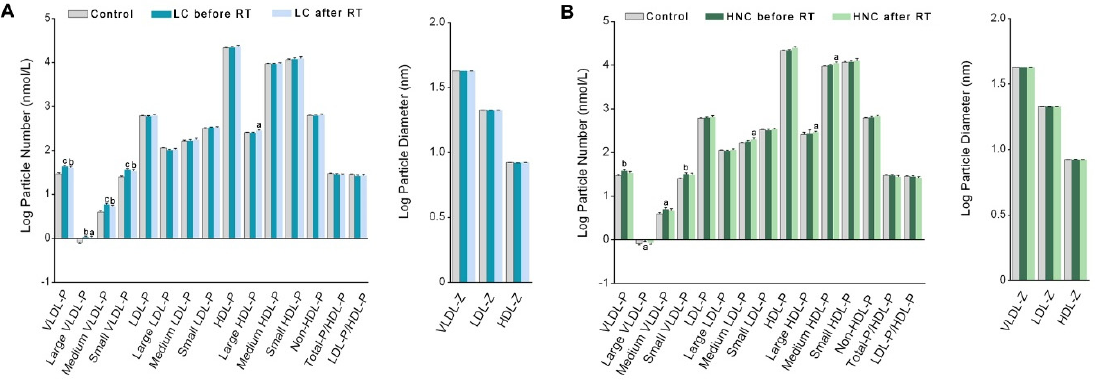
Figure 2. Number and diameter of the different lipoprotein particles in patients with lung cancer (LC) ( A ), head and neck cancer (HNC) ( B ) before and after radiotherapy (RT) and in the control group. Values are log transformed due to the high variability of particle sizes and numbers. Results are shown as means and standard errors. HDL: high-density lipoproteins; IDL: intermediate-density lipoproteins; LDL: low-density lipoproteins; VLDL: very-low-density lipoproteins. The suffix –P indicates number of particles, and the suffix –Z indicates the particle diameter. a p < 0.05, b p < 0.01, c p < 0.001, with respect to the control group by the Mann-Whitney U -test.